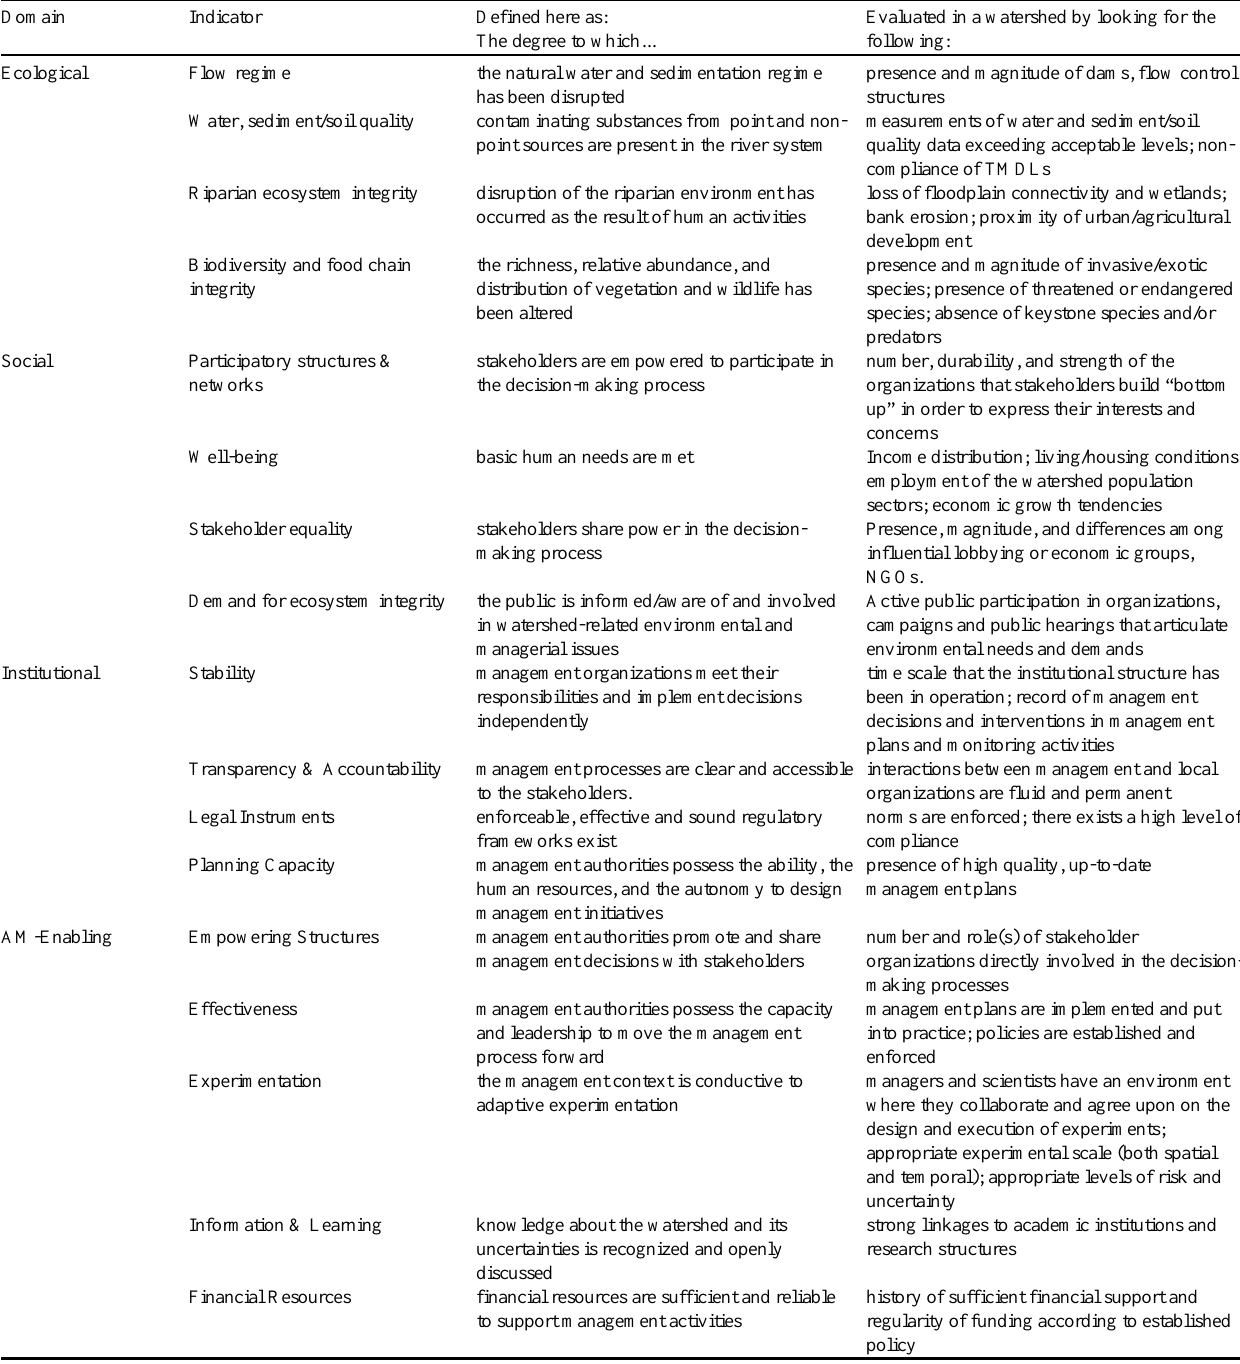
Table 1 . Definition of Index of Management Condition Indicators and the criteria used for scoring.